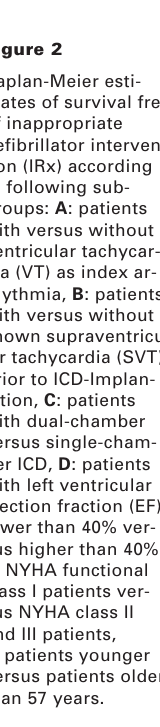
Kaplan-Meier esti- mates of survival free of inappropriate defibrillator interven- tion (IRx) according to following sub- groups: A : patients with versus without ventricular tachycar- dia (VT) as index ar- rhythmia, B : patients with versus without known supraventricu- lar tachycardia (SVT) prior to ICD-Implan- tation, C : patients with dual-chamber versus single-cham- ber ICD, D : patients with left ventricular ejection fraction (EF) lower than 40% ver- sus higher than 40%, E : NYHA functional class I patients ver- sus NYHA class II and III patients, F : patients younger versus patients older than 57